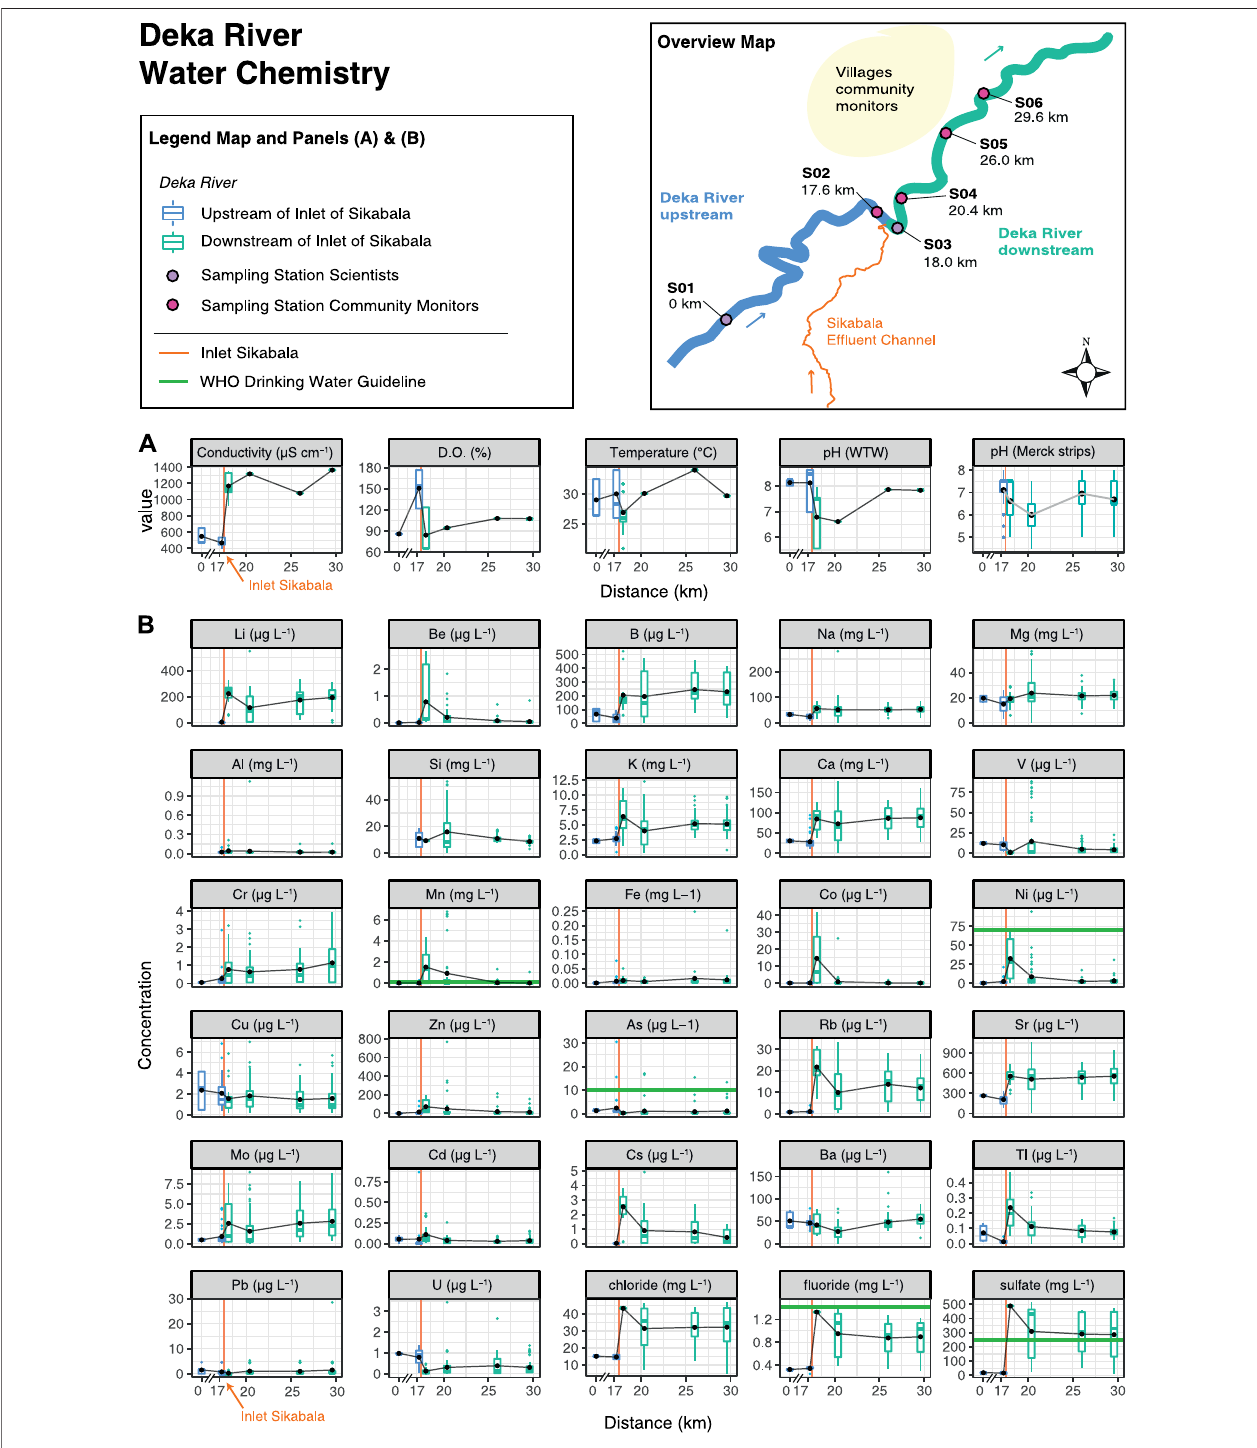
FIGURE 2 | Overview map shows sampling locations in Deka River upstream (blue) and downstream (green) with respect to inlet of Sikabala ef fl uent channel (orange). (A) Boxplots of fi eld parameters of Deka River. (B) Boxplots of dissolved metal concentrations from 298 unacidi fi ed samples (out of which 276 grab samples) taken between December 14, 2018 and March 31, 2020 in Deka River. WHO water quality thresholds (WHO, 2017) are shown as horizontal green lines if exceeded. Blackdotsrepresentaveragevaluesandblacklinesindicate trendbetweenthem. X -axisisdiscontinued between0and17 kmtick,namelybetweenthetwoDeka River upstream sampling stations. Orange vertical line indicates position of Sikabala inlet.